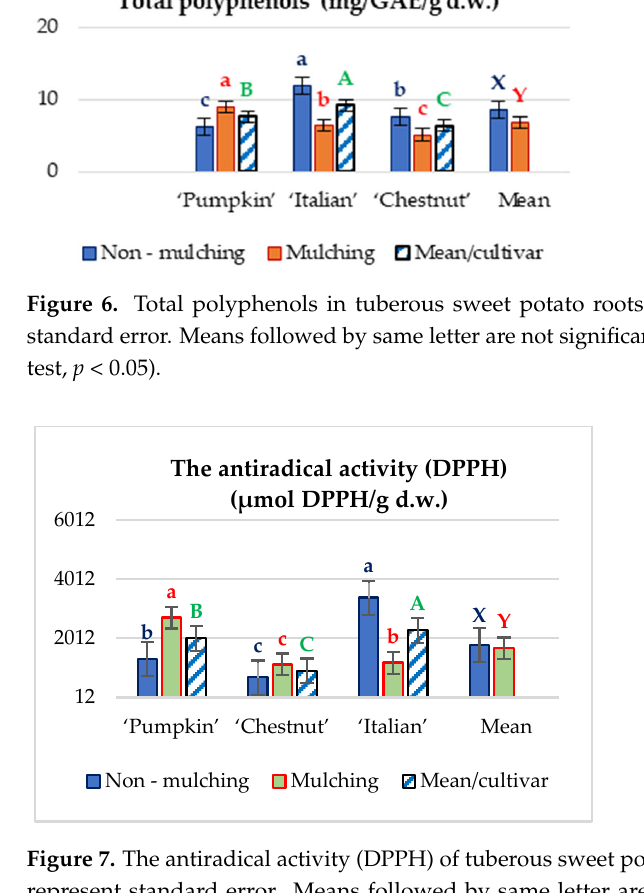
Figure 7. The antiradical activity (DPPH) of tuberous sweet potato roots ( μ mol DPPH/g d.w.). Bars represent standard error. Means followed by same letter are not significantly different (Tukey’s multiple range test, p < 0.05).